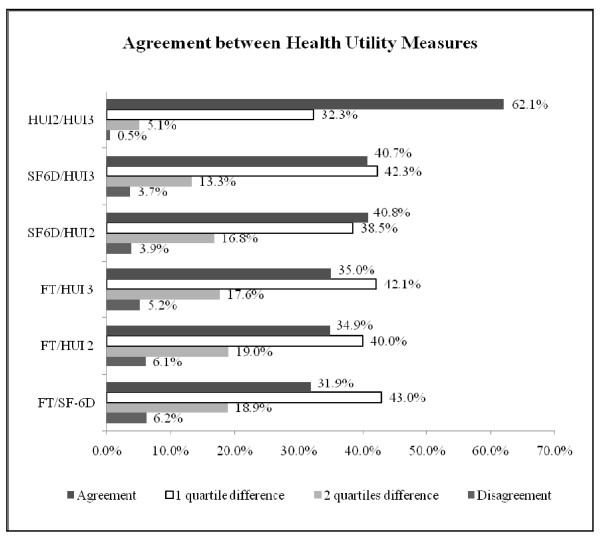
Within quartile agreement between instruments by quartile. HUI = Health Utilities Index, FT = Feeling Thermometer, SF-6D = Short Form-6 Dimensions, Disagreement = top quartile of one score, lowest quartile of other score, Significantly higher % agreement: HUI2/HUI3 versus all others (P < 0.001):, SF-6D/HUI3 versus FT/HUI3, FT/HUI2, FT/SF-6D (all P < 0.001), SF-6D/HUI2 versus FT/HUI3 (P = 0.008), FT/HUI2 (P = 0.003), FT/SF-6D (P < 0.001), FT/HUI3 versus FT/SF-6D (P = 0.04).